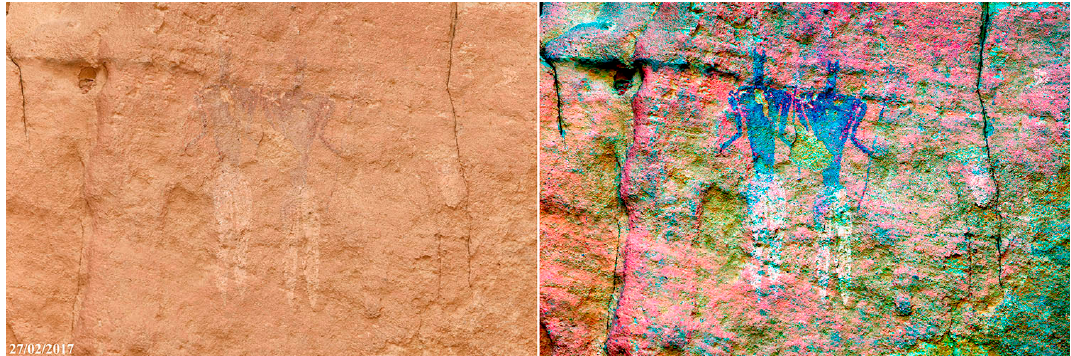
Figure 9. Two warriors armed with spears at P4 (Photo: Alessandro Menardi Noguera). The pointed terminations of their heads recall animal ears (enhanced version to the right in DStretch LAB colour space).